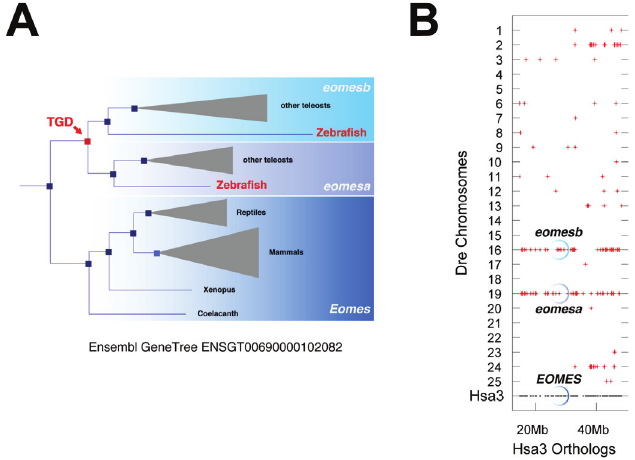
Figure S1. Teleost eomes genes. A . The topology of the Ensembl Gene Tree suggest that the teleost eomes co-orthologs, eomesa and eomesb , were duplicated at the base of the teleost lineage and thus most likely during the teleost genome duplication (TGD). B . Dotplot from the Synteny Database shows that the human EOMES gene region on chromosome Hsa3 shows extensive double conserved synteny to zebrafish chromosomes Dre19 and Dre16 which contain eomesa and eomesb , respectively, providing strong evidence for the TGD origin of teleost eomes co-orthologs.